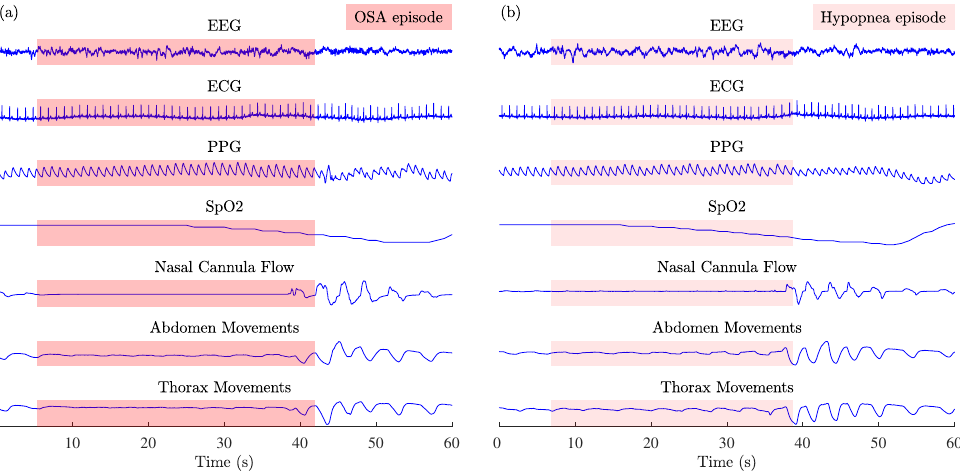
Figure 1. Examples of MESA multichannel physiological signals recorded during ( a ) OSA and ( b ) hypopnea episodes: electroencephalogram (EEG), electrocardiogram (ECG), photoplethys- mogram (PPG), arterial blood oxygen saturation (SpO2), nasal cannula flow, abdomen, and thorax